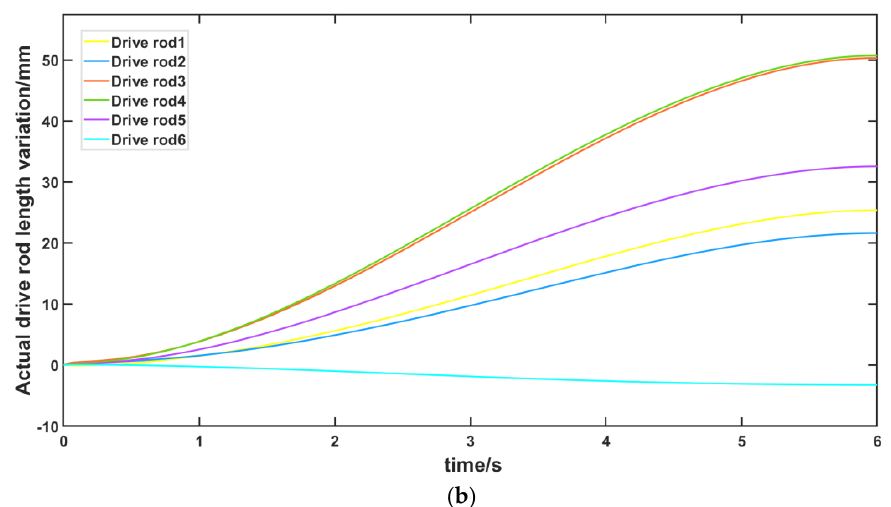
Figure 16. Length change curve of driving rod in moving platform: ( a ) expected drive rod length change curve with time; ( b ) actual driving rod length variation curve with time.